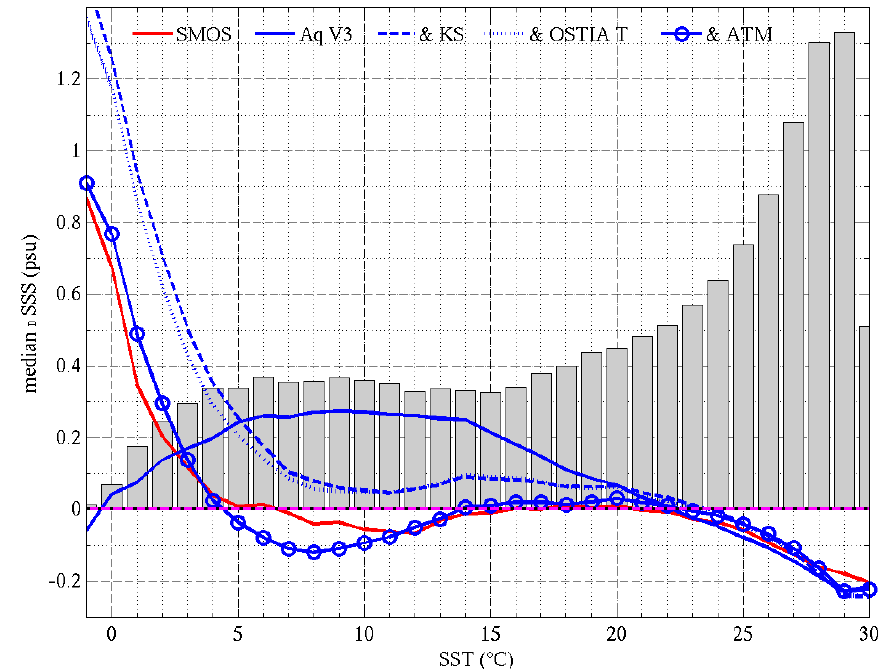
Figure 16. Comparison of SST-dependent bias between SMOS and Aquarius and impact of retrieval parameters. The plot reports the difference between satellite and in situ SSS binned as a function of SST and computed from monthly SSS maps over the period Sept 2011–May 2015. Satellite SSS are (Red) SMOS, and (Blue) Aquarius V3. The Aquarius V3 curves are for (plain) the nominal product, (dashed) V3 reprocessed using the KS dielectric constant model, (dotted) using KS model and OSTIA ancillary SST, and (plain and circles) using the KS model, the OSTIA SST and the adjusted atmospheric model from Aquarius V5.